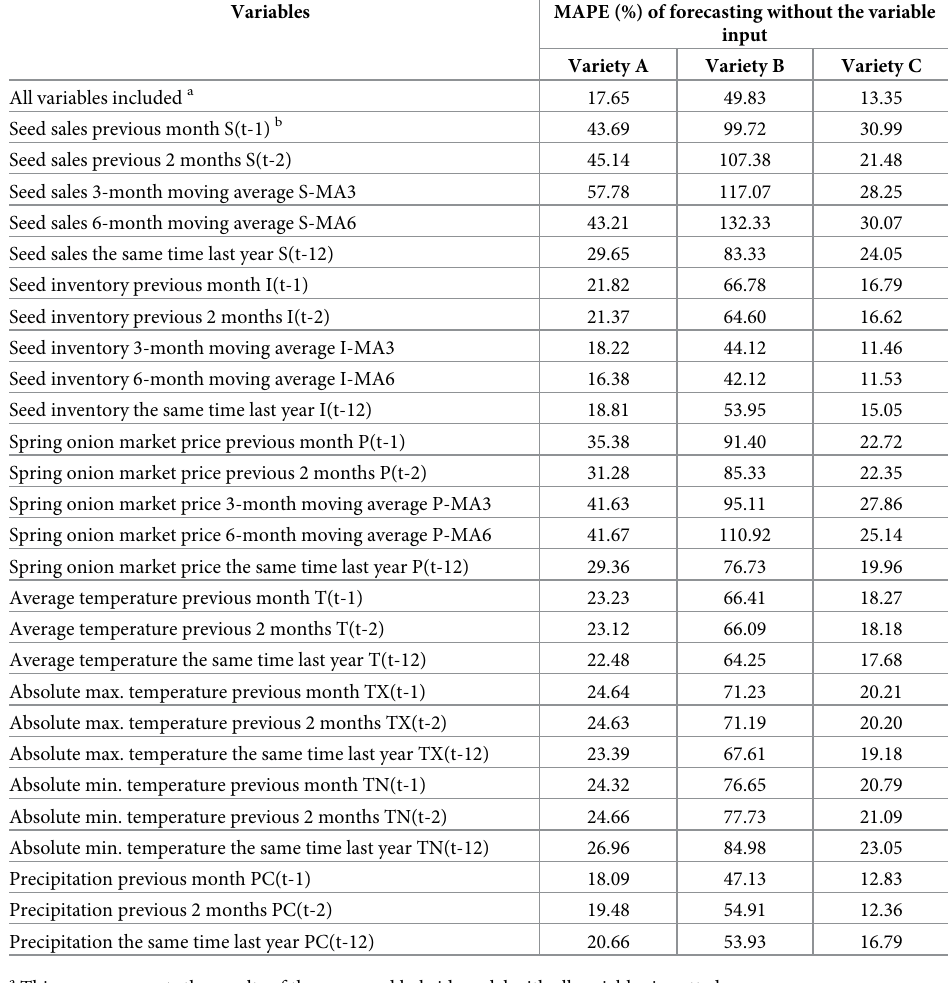
Table 1. The forecasting performance of the proposed hybrid model with different variables of dynamic factors